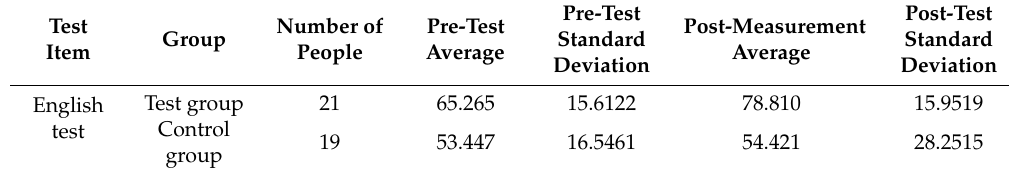
Table 2. The English knowledge of the control and experimental groups, measured before and after the English teaching conducted by the teacher. The results illustrate the overall learning performance of both groups, but further statistical evaluation is required to identify the performance of each individual test